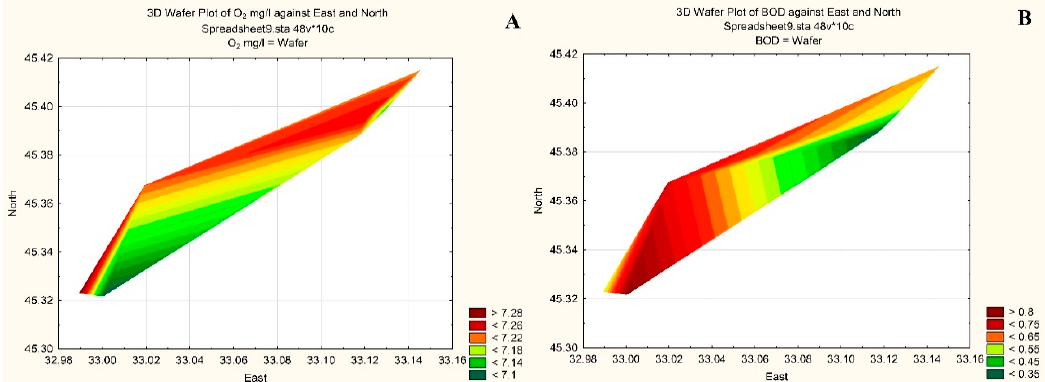
Figure 6. The average annual concentrations of dissolved oxygen ( A ) and BOD 5 ( B ) in the water column at the sampling stations in the Donuzlav Gulf of the Black Sea.